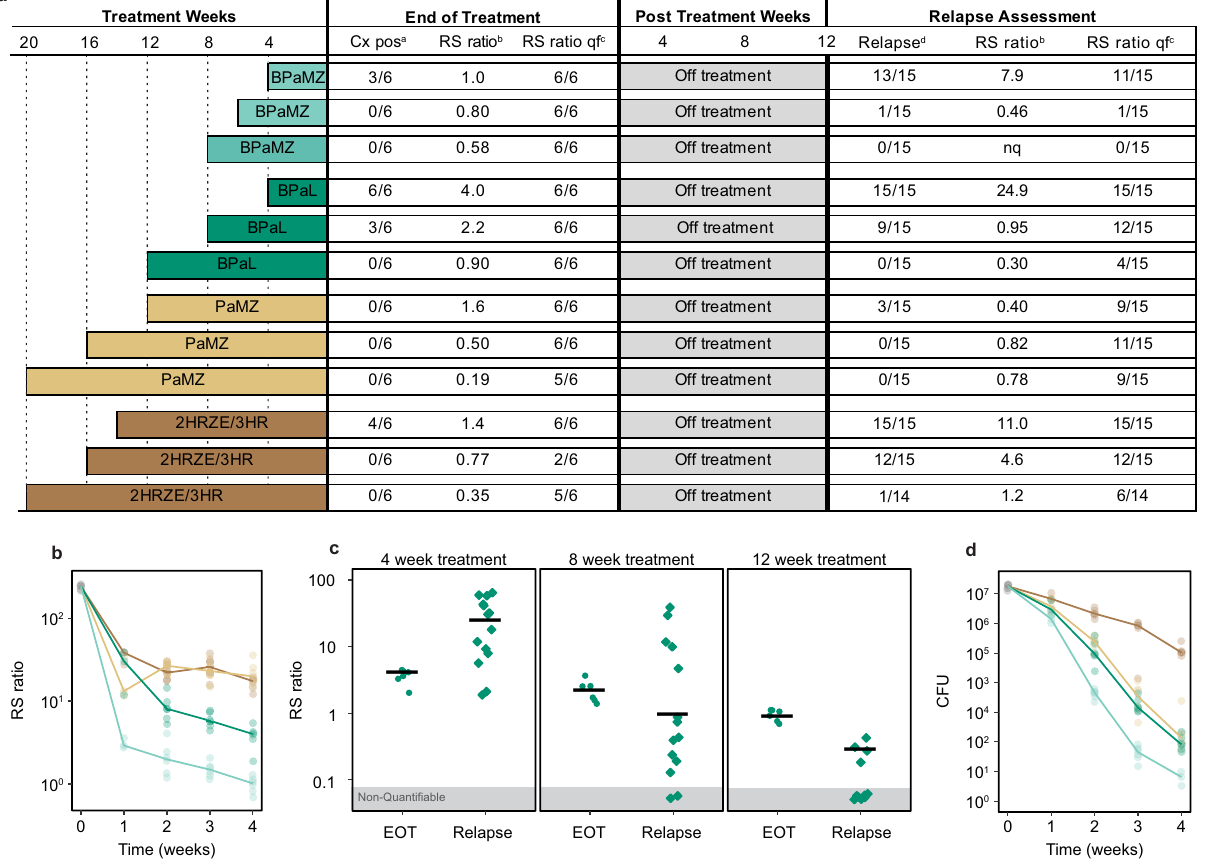
(Fig. 5b, c). During weeks 1 – 4, CFU grouped PaMZ with BPaL while the RS ratio grouped PaMZ with HRZE. However, after 20 weeks, PaMZ suppressed the RS ratio signi fi cantly more ( P = 0.03) than HRZE. PaMZ was also more effective than HRZE in preventing both rebound in the RS ratio and relapse following the completion of treatment. After 14 weeks of HRZE and a 12-week drug holiday, the RS ratio rebounded (median = 11.0) and all mice relapsed. By contrast, after 12 weeks of PaMZ and a 12-week drug holiday, the RS ratio remained suppressed (median = 0.40)